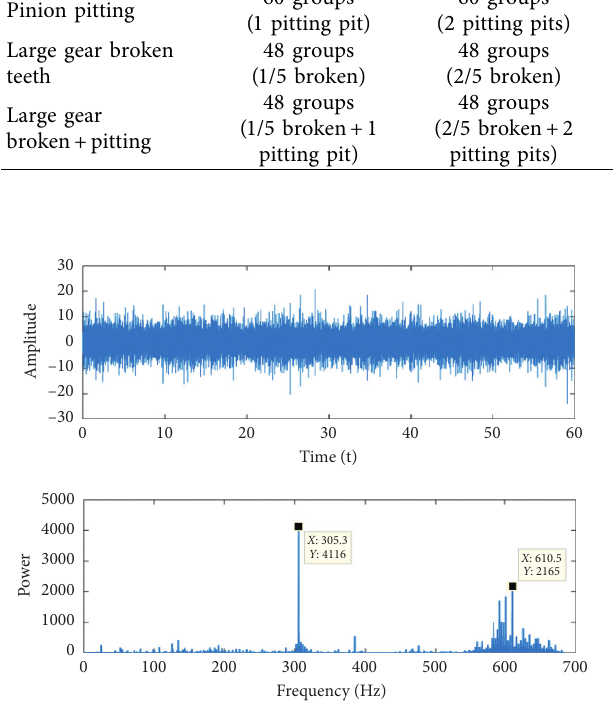
Figure 18: Time domain and frequency domain diagram for signal of normal state gear.